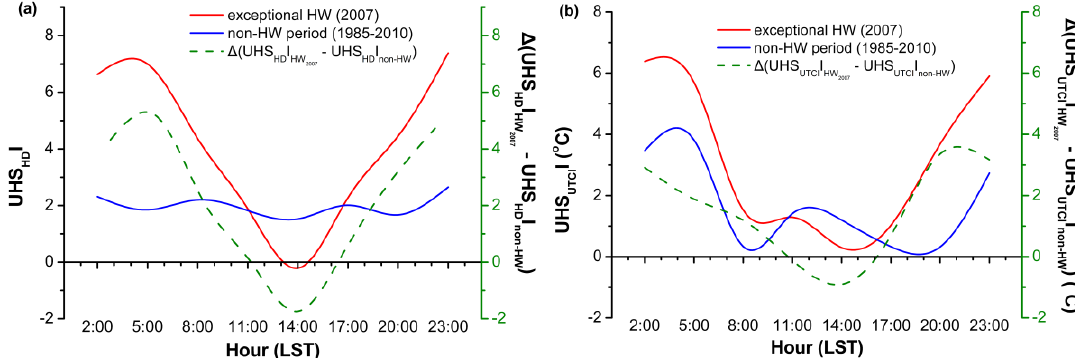
Figure 7. Diurnal variation of ‘Urban Heat Stress Intensity’ (UHSI) based on ( a ) HD; ( b ) UTCI for the exceptional HW of June 2007 and for a non-HW period which is represented from the calendar dates of June 2007 HW covering the 1985 – 2010 period excluding any HWs that falls in these days. The UHSI is quantified by the difference of heat stress between the urban station of NOA and the suburban station of Tatoi.